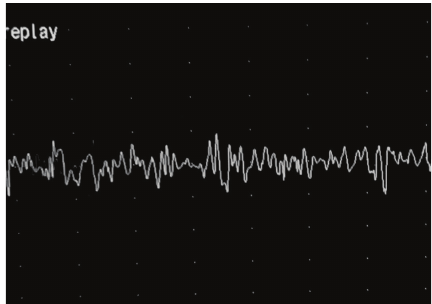
Figure 2: Laryngeal electromyography of the normal LCA.